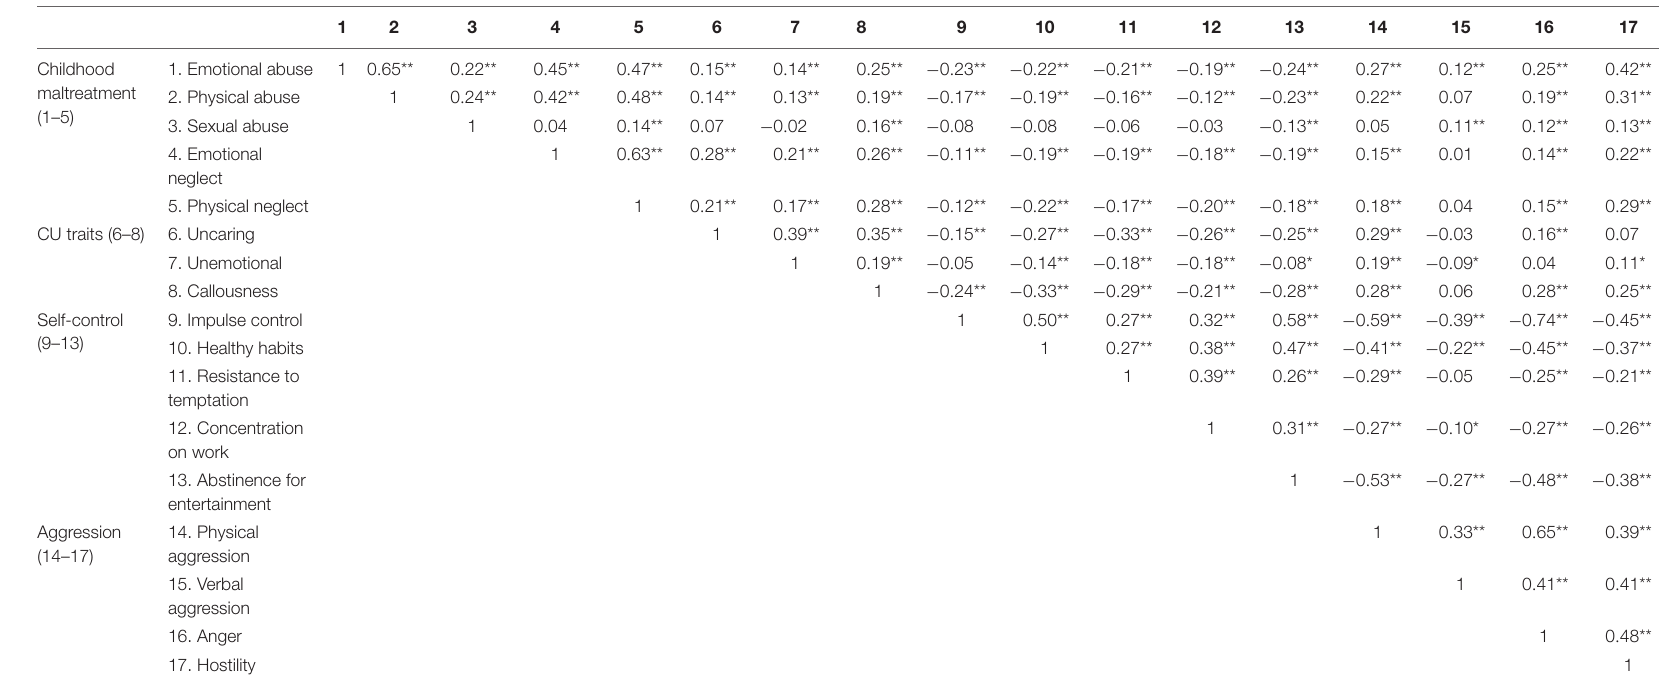
TABLE 2 | Correlations among the scores of